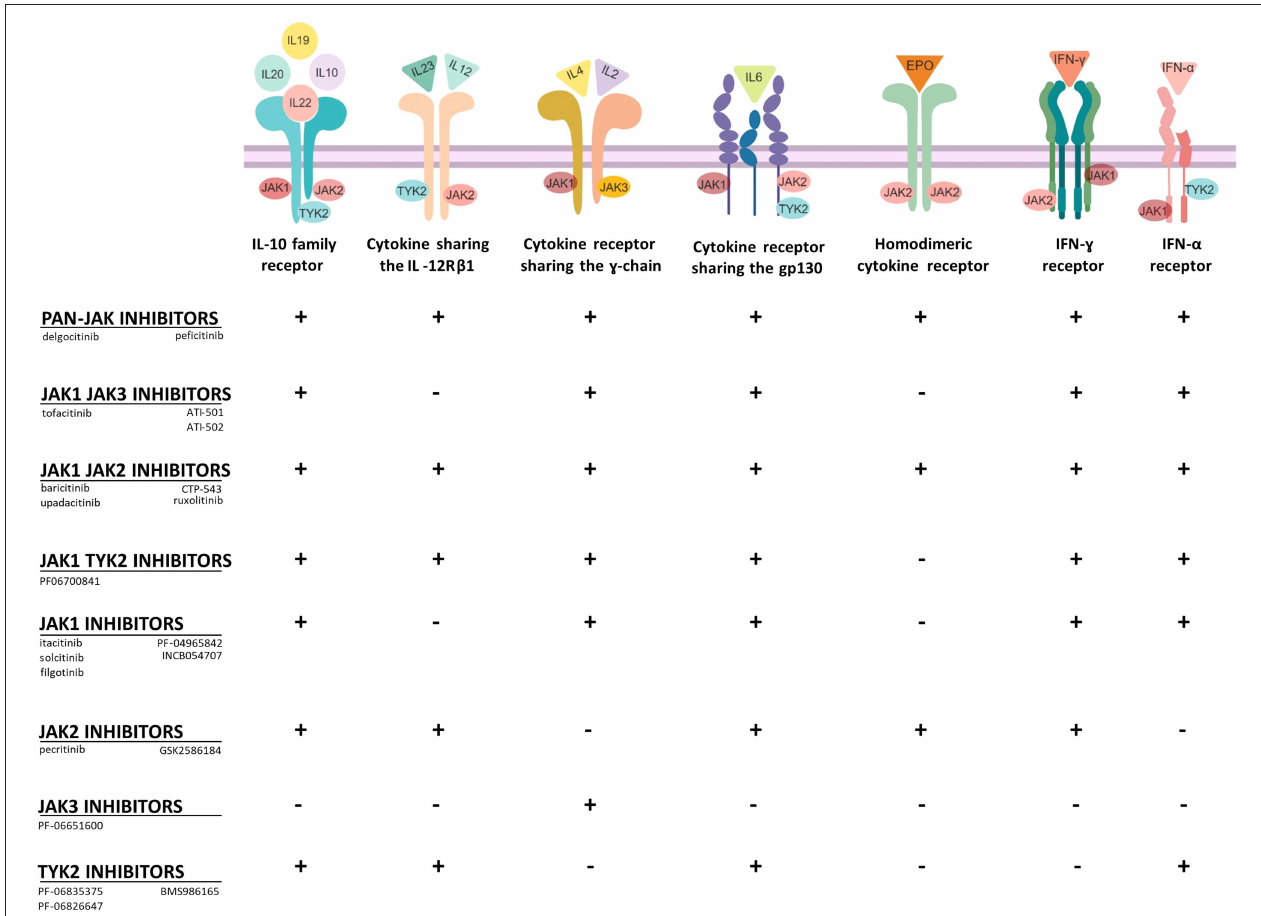
FIGURE 2 | Selectivity of JAKi toward type I and type II cytokine receptors. JAKi display different capacities to block cytokine receptor signaling. Pan-JAK inhibitors for example have a broad inhibitory effect, while drugs, which target selectively JAK3 or TYK2 have a more limited mode of action ( + , inhibition; -, no inhibition). Figure was created with the help of